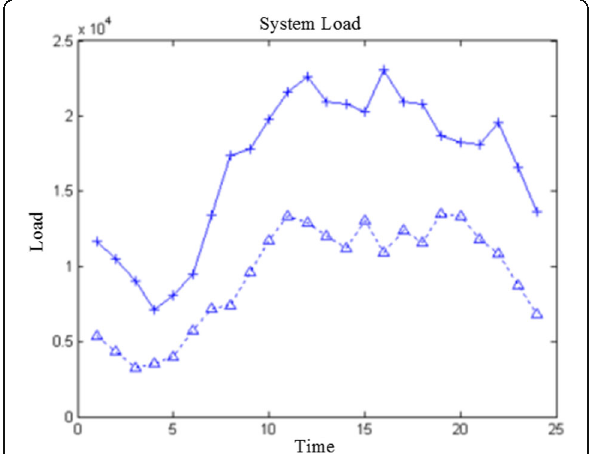
Fig. 10 The profile of original Shapeable